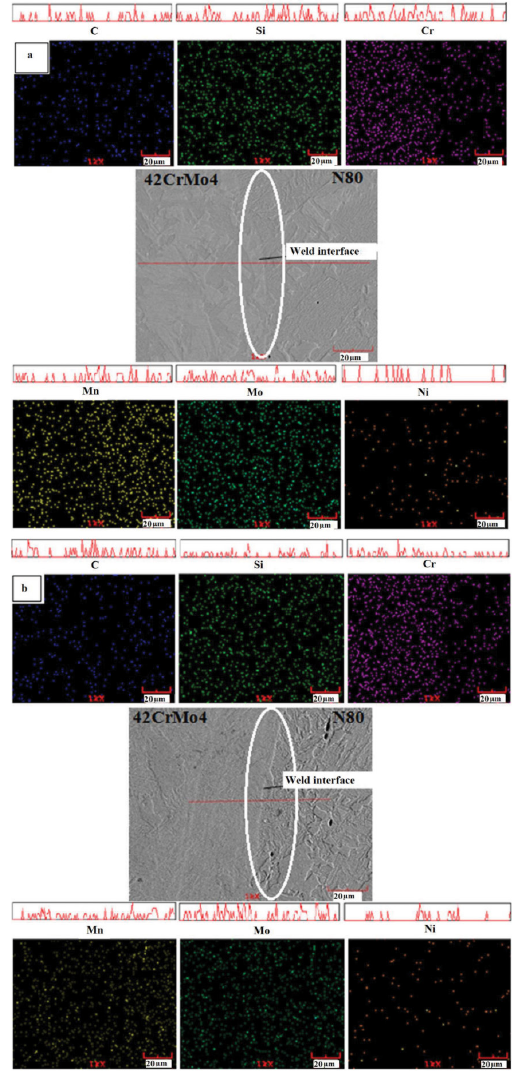
Figure 4. The elemental mapping result of a) as-welded b) Stress relief annealed N80-42CrMo4 couple.